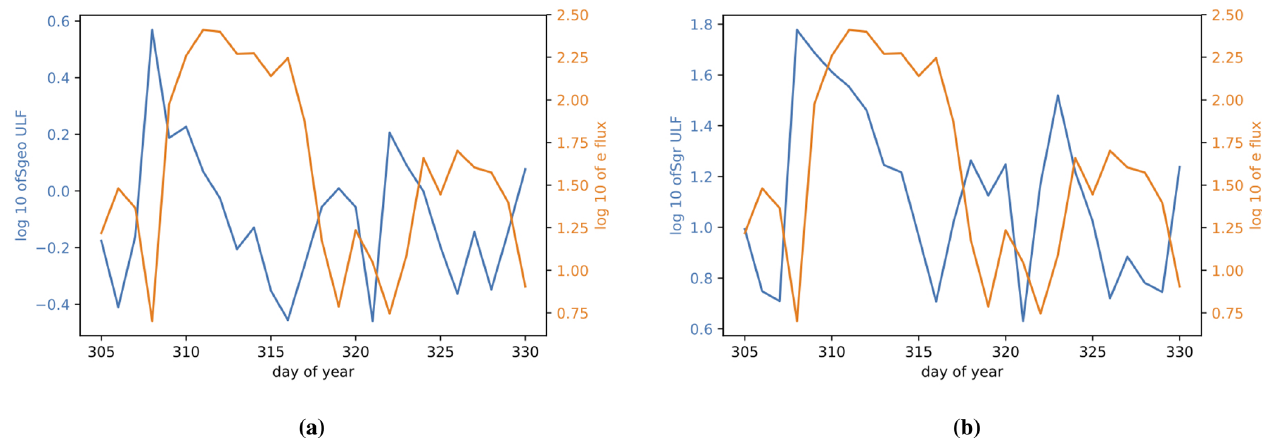
Figure 3. (a) The 24h average of relativistic electron flux index F e 1 . 2 and geosynchronous ULF index S geo for the 1993 event from the Rostoker et al. (1998) study. (b) Same as for panel (a) but with ground ULF index S gr for the 1993